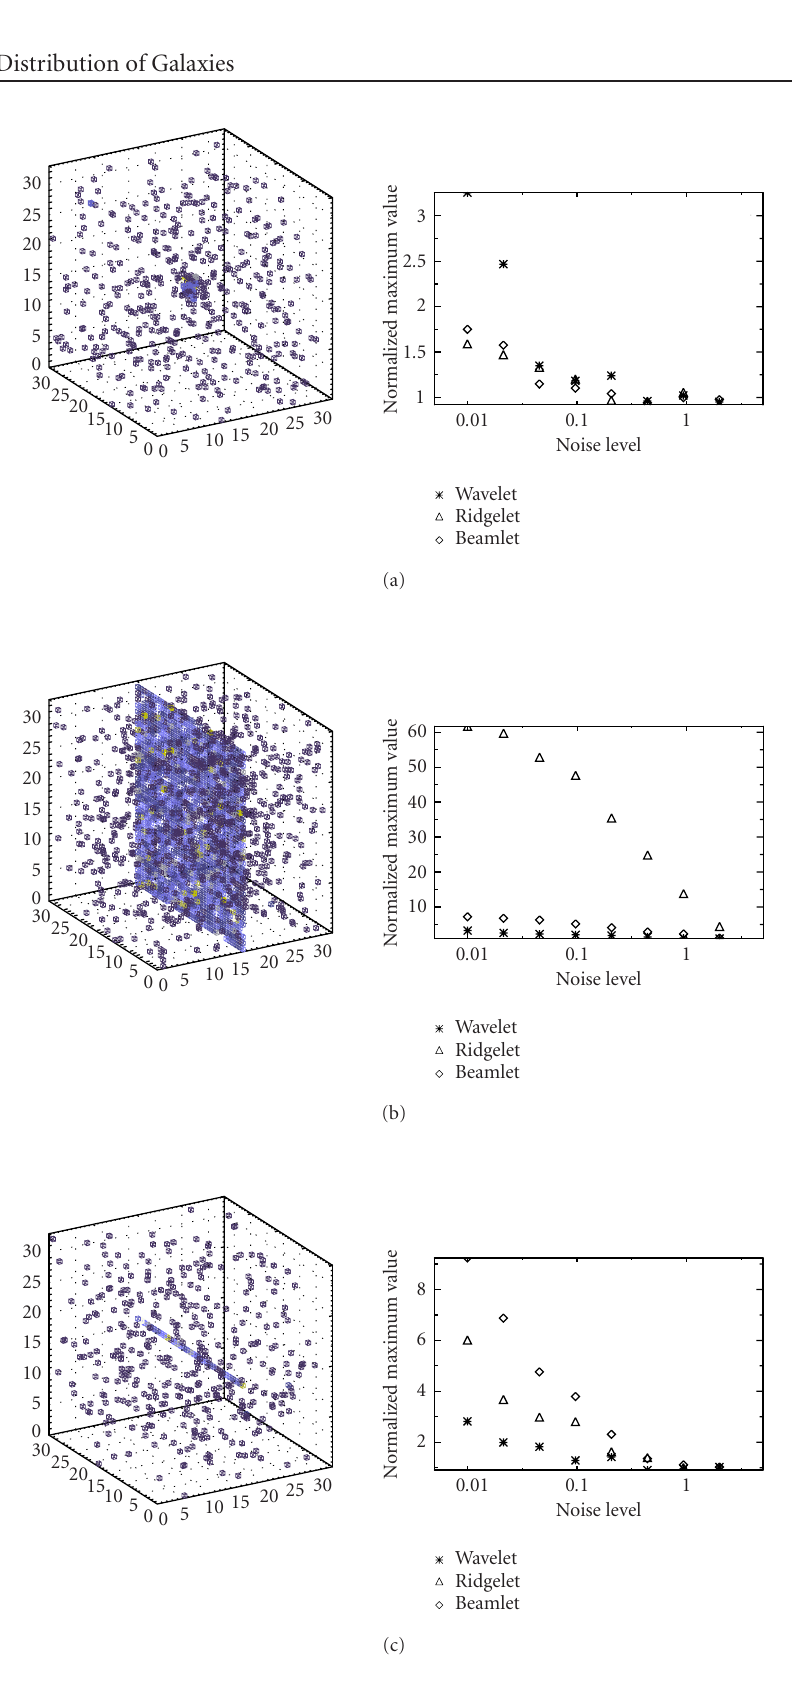
Figure 10: Poisson realization for a low noise level: simulation of cubes containing (a) a cluster , (b) a plane, and (c) a